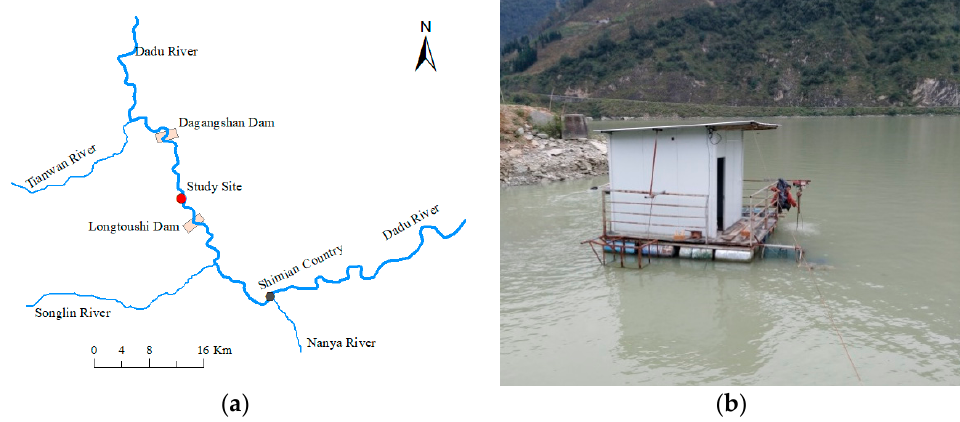
Figure 1. ( a ) Study site located 12 km downstream of Dagangshan Dam in the Dadu River; ( b ) Photograph of a test facility.